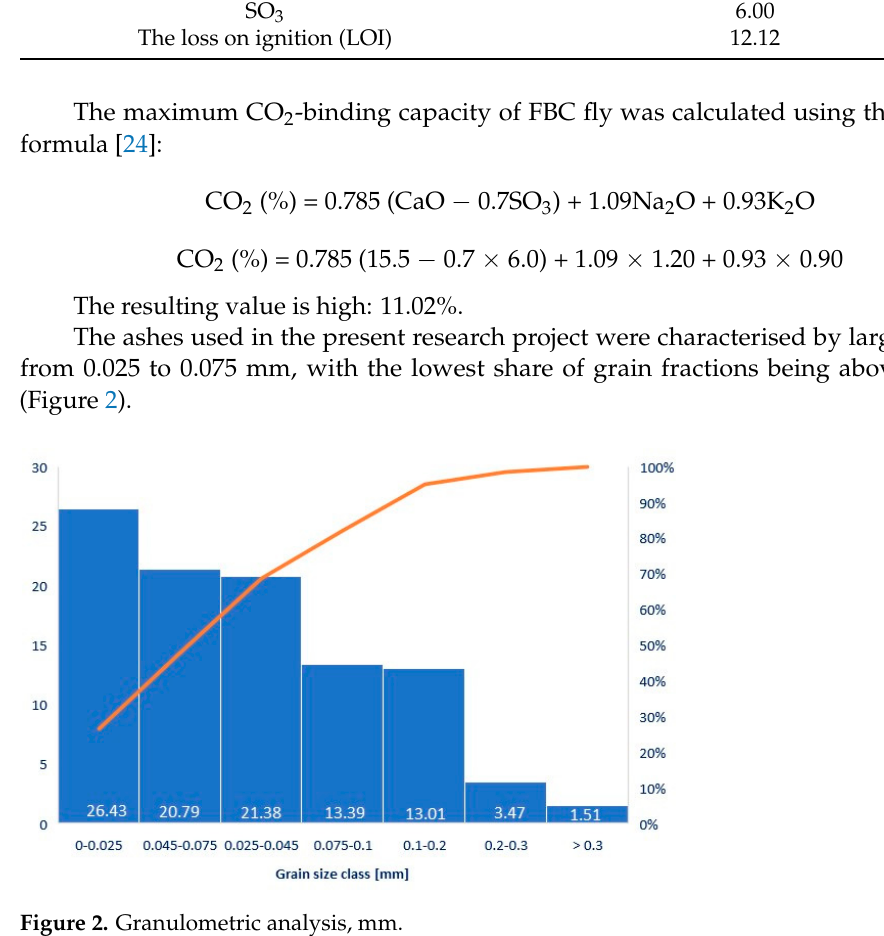
Figure 2. Granulometric analysis, mm.